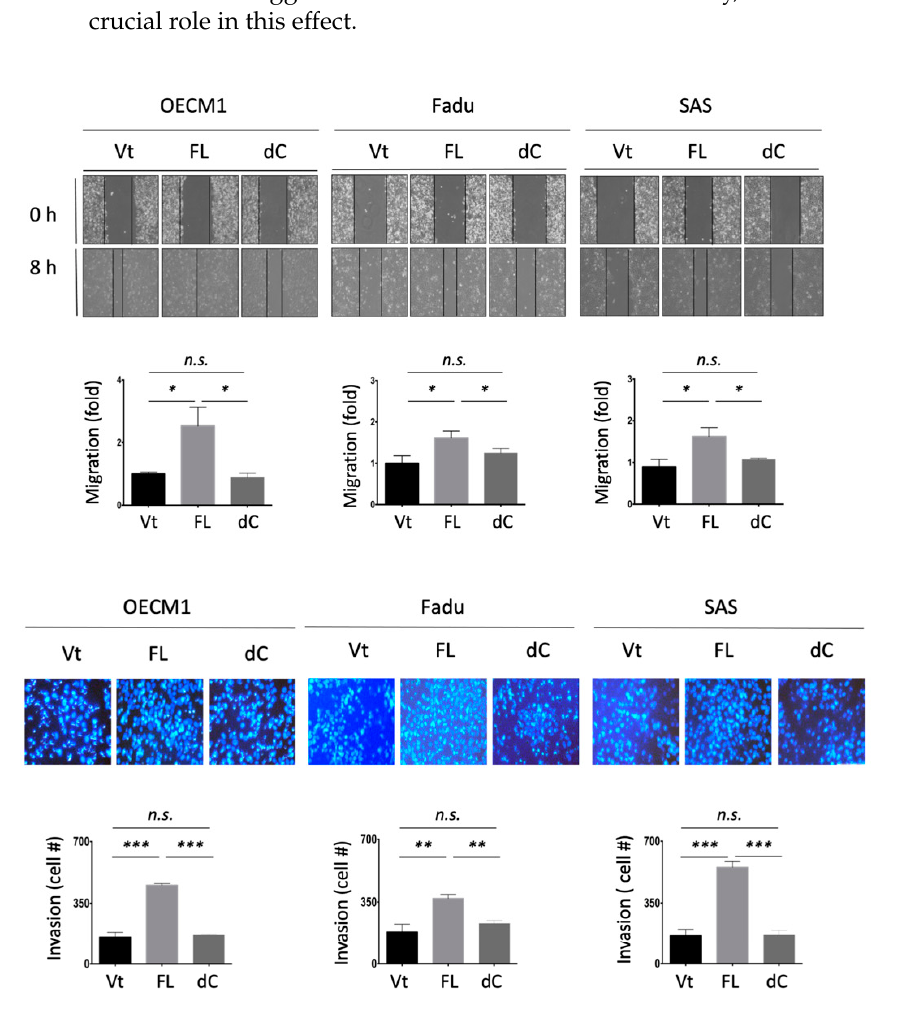
Figure 5. NDRG1-3R motif is critical for cellular motility. ( a ) Deletion of the C-terminal domain significantly attenuated NDRG1-induced cell migration. After transfection of the NDRG1-FL, NDRG1-dC, or the vector plasmid into HNC cells, the cells were subjected to wound healing migration analysis. ( b ) Deletion of the C-terminal domain significantly inhibited NDRG1-induced cell invasion. After transfection of the NDRG1-FL, NDRG1-dC, or the vector plasmid into HNC cells, the cells were subjected to Matrigel invasion assay. ( c ) Deletion of the C-terminal domain suppressed NDRG1-induced ECM-associated molecules. After transfection of the NDRG1-FL, NDRG1-dC, or the vector plasmids into HNC cells, cellular proteins were extracted and subjected to Western blot analysis. The GAPDH was used as an internal control. All the experiments were performed three times independently and typical results were shown. The error bars shown in the relevant figures indicate the standard deviation of the quantification results. (* p < 0.05; ** p < 0.01; *** p < 0.001; t -test).